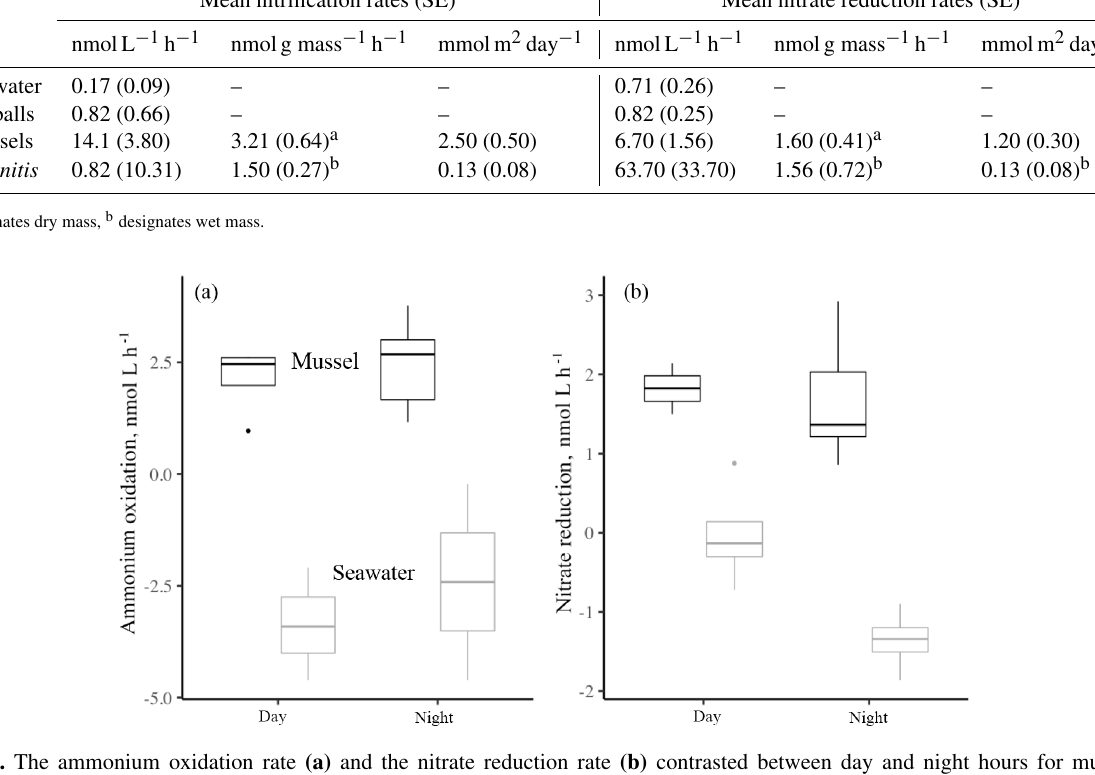
Figure 2. The ammonium oxidation rate (a) and the nitrate reduction rate (b) contrasted between day and night hours for mussels or seawater at the shore. Data are log-transformed (from nmolL − 1 h − 1 ) to facilitate comparison. Rates with mussels were always greater (for a F 1 , 11 = 52 . 59, p< 0 . 001; and b F 1 , 14 = 68 . 14, p< 0 . 001). Ammonium oxidation rates in association with mussels or in seawater alone did not differ between day and night ( F 1 , 11 = 0 . 58, p = 0 . 461), while nitrate reduction in seawater was greater during the day ( F 1 , 14 = 5 .